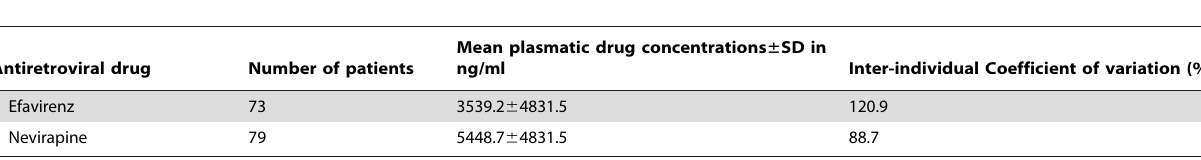
Table 3. Inter-individual variability for Efavirenz and Nevirapine among 152 participants.